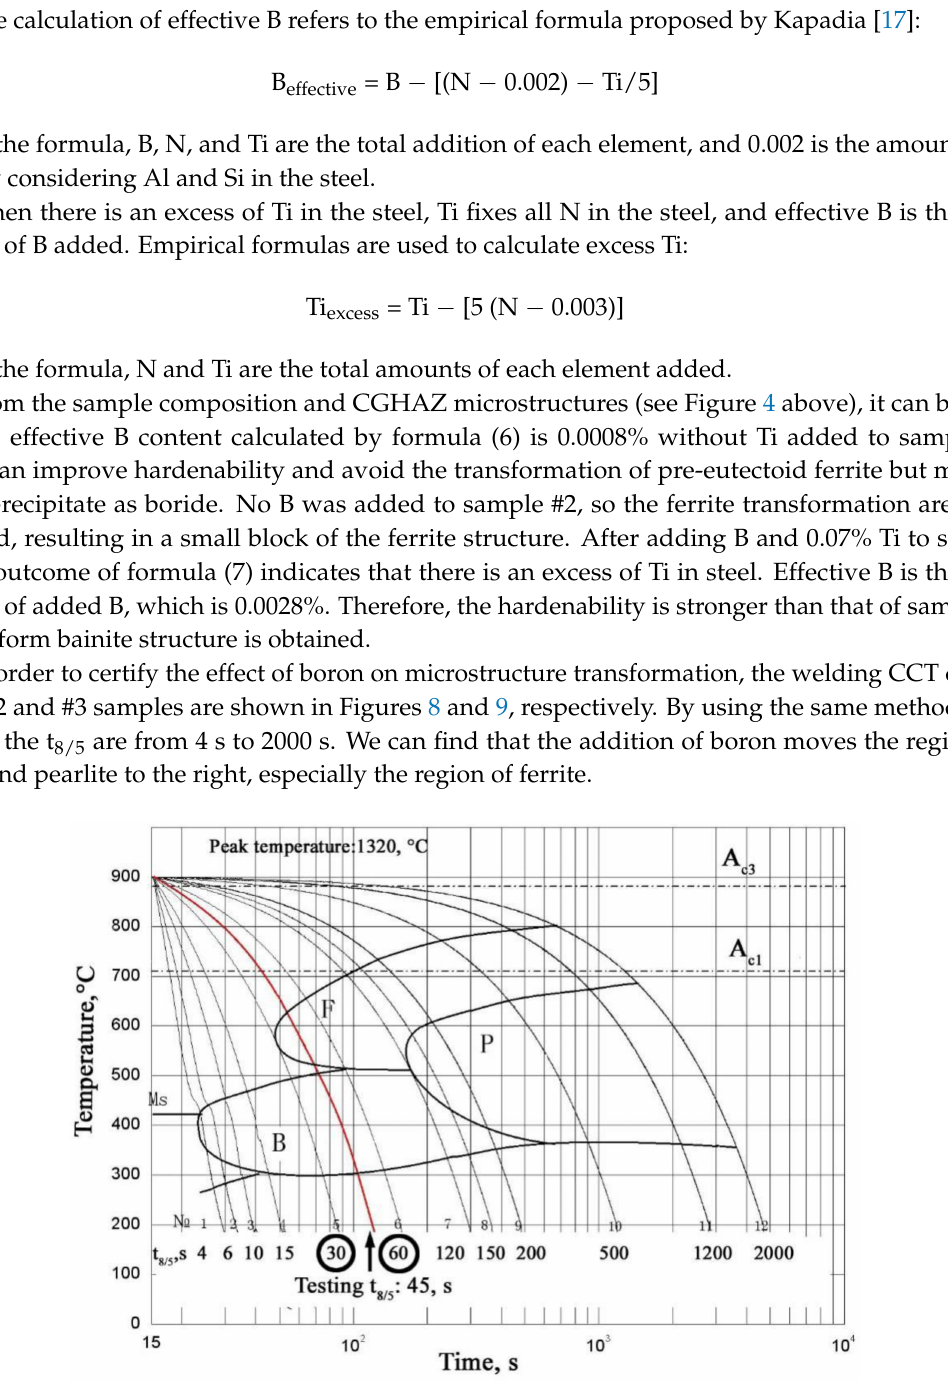
Figure 8. Welding CCT curve of #2